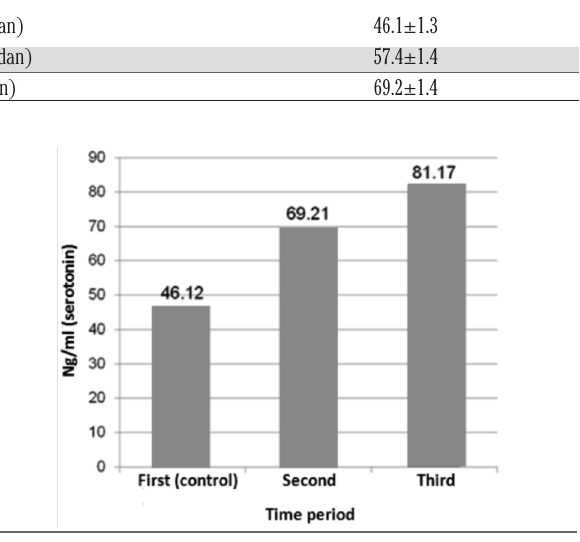
P<0.05.Figure 3. Effect of fasting on dopamine levels on 14 th (second) and 29 th (third) day of Ramadan compared to the control group. All data are expressed as mean±standard error of mean;